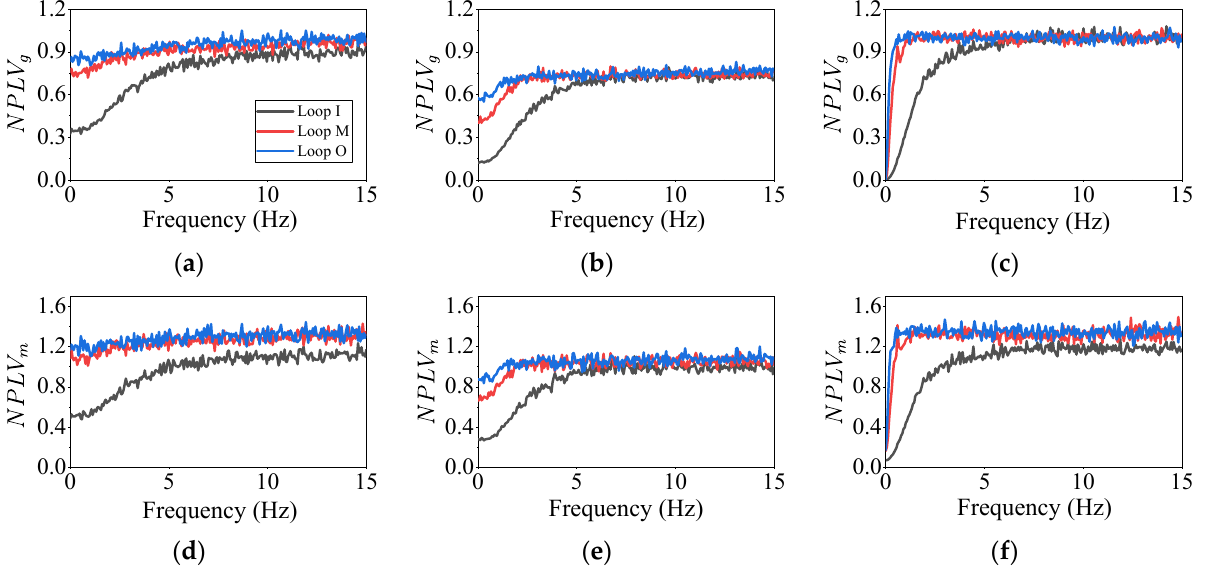
Figure 12. Influence of spectral coherence models ( a ) HV1, ( b ) HV2, ( c ) LW, ( d ) HV1, ( e ) HV2, and ( f ) LW on the NPLVs calculated by ( a – c ) Gaussian model and ( d – f ) modified Gaussian model.